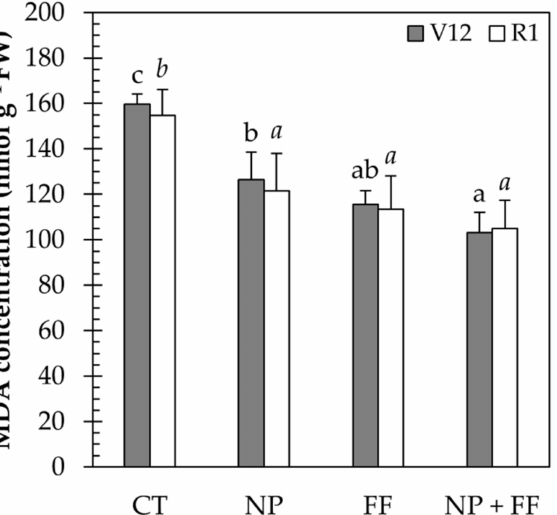
Figure 3. Changes in MDA concentration of maize leaves due to each treatment at different phenolog- ical stages (V12 and R1). Data represent mean ± SD (n = 5); CT: untreated control; FF: foliar fertilizer; NP: nitrapyrin; NP + FF: joint treatment of nitrapyrin and foliar fertilizer. Different lowercase letters denote significant differences (one-way ANOVA and Duncan’s multiple range test, p ≤ 0.05) between the different